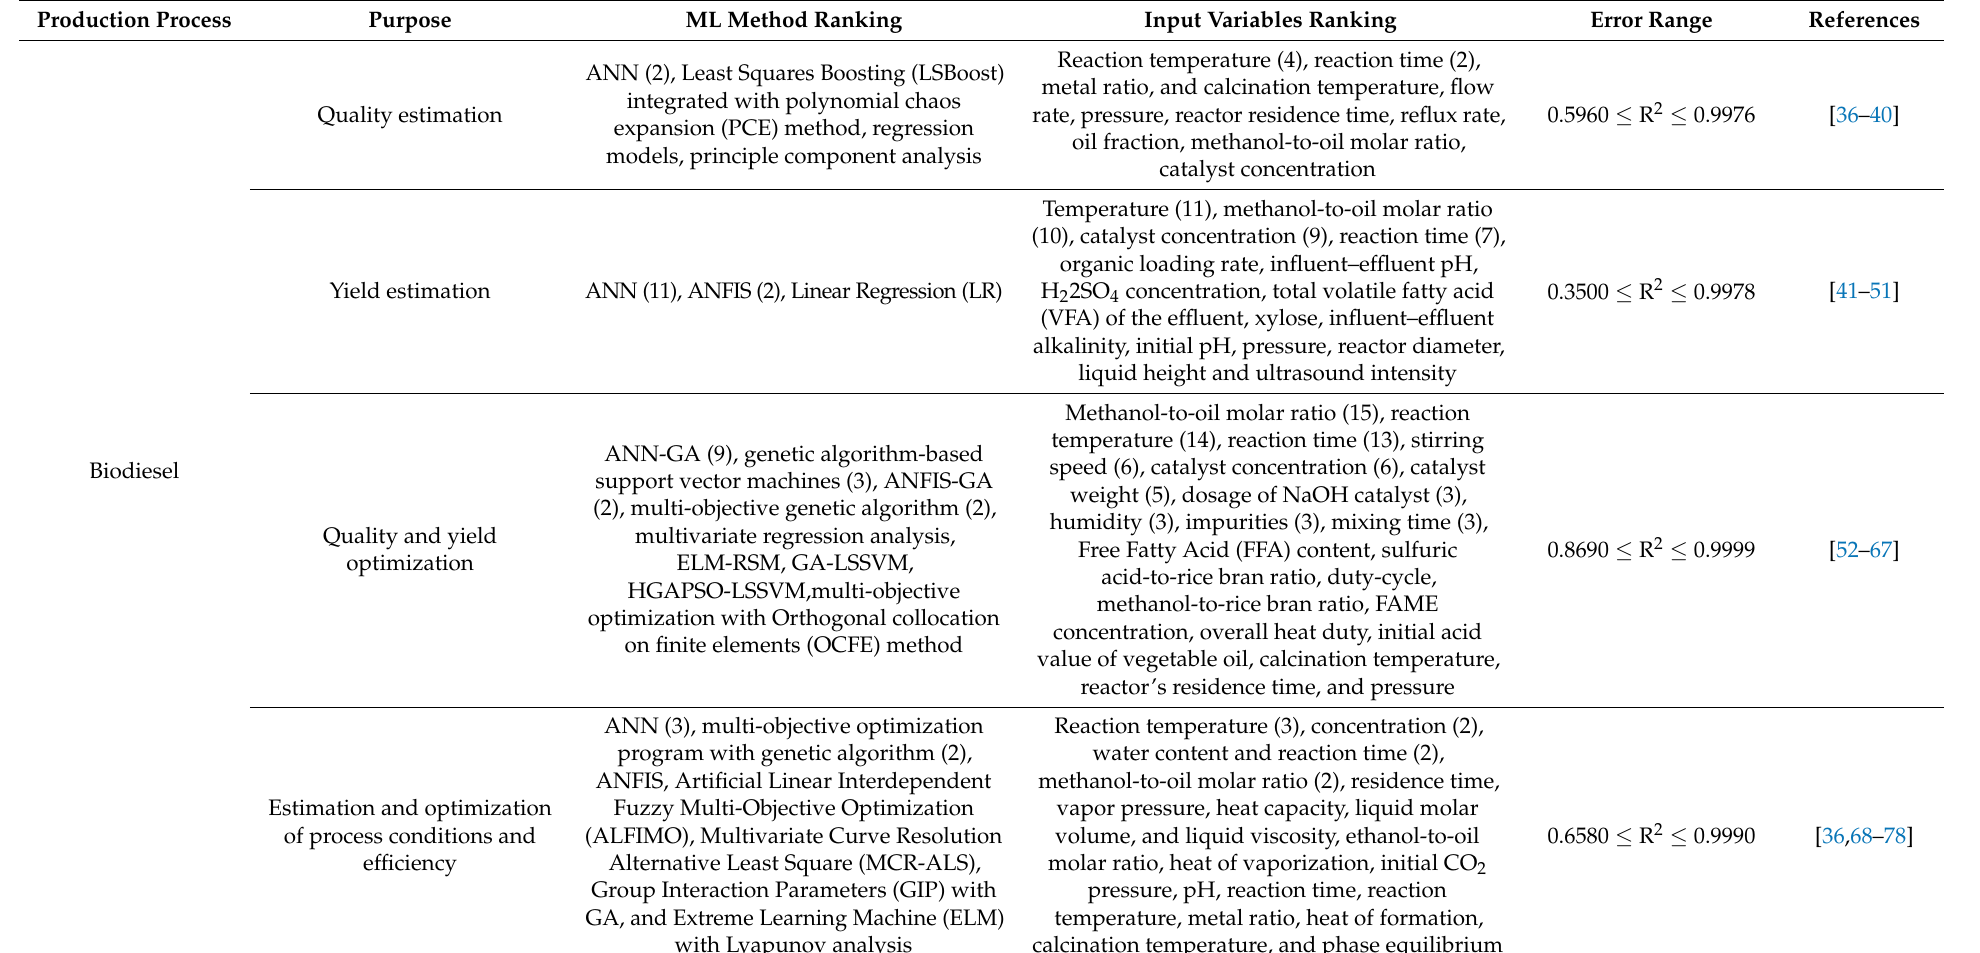
Table 4. Summary of ML applications in the production phase. (The numbers in round brackets indicate the number of papers for the preceding